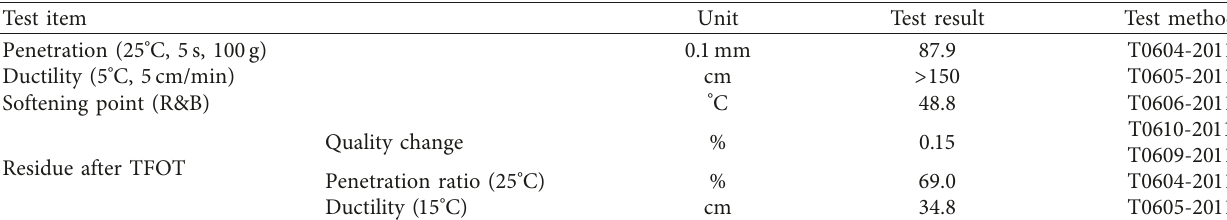
Table 1: Properties of base